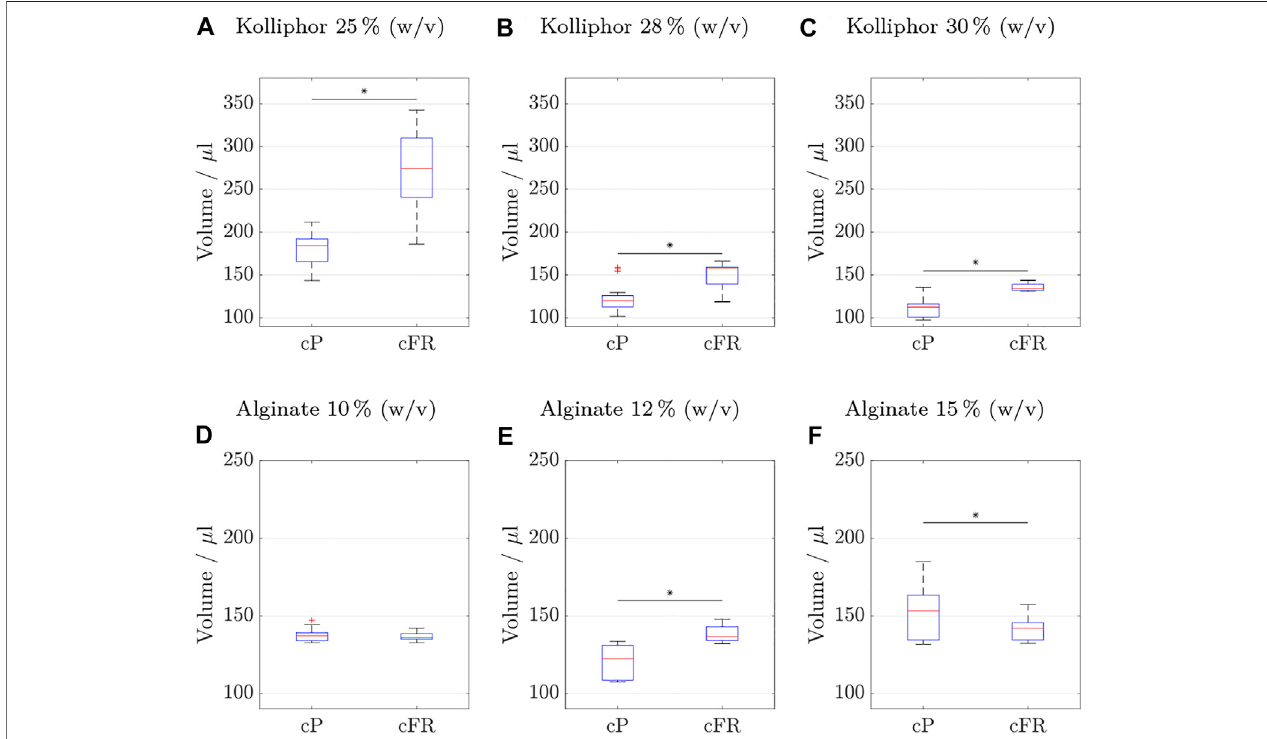
FIGURE8| Cylindervolumes( n run =6with n sample =3resultingin18cylinders)ofthereproducibilitytestcomparingthetwoprocessstrategies:ontheleftsideusing constantpressure(cP)andontherightsideapplyingaconstant fl owrate(cFR).Valuesareconsideredoutliersiftheyaremorethan1.5timestheinterquartilerangefrom the bottom or top of the box. The results obtained with inks containing different Kolliphor concentrations are shown in (A – C) and with inks containing different alginate concentrationsin (D – F) .Statisticallysigni fi cantdifferences betweencFRandcPwerefoundbetweenalldatasetsexceptforinkcontaining10%(w/v)alginate. The